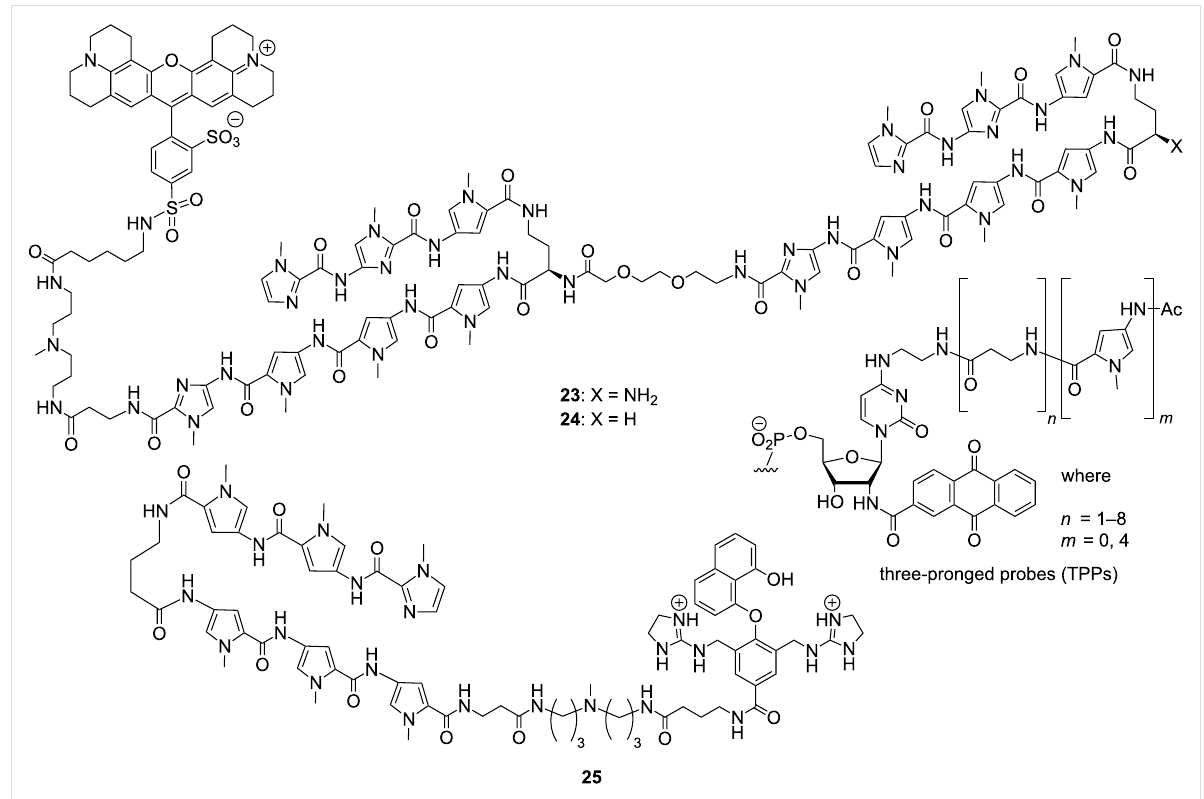
Figure 8: Telomere-targeting tandem hairpin Py/Im polyamides 23 and 24 capable of recognizing >10 base pairs; 25 : a novel DNA-cleaving agent comprising of bis(guanidinium)alcohol tethered with Dervan hairpin polyamide; three-pronged probes (TPPs) to target A·T-rich sequences selectively.